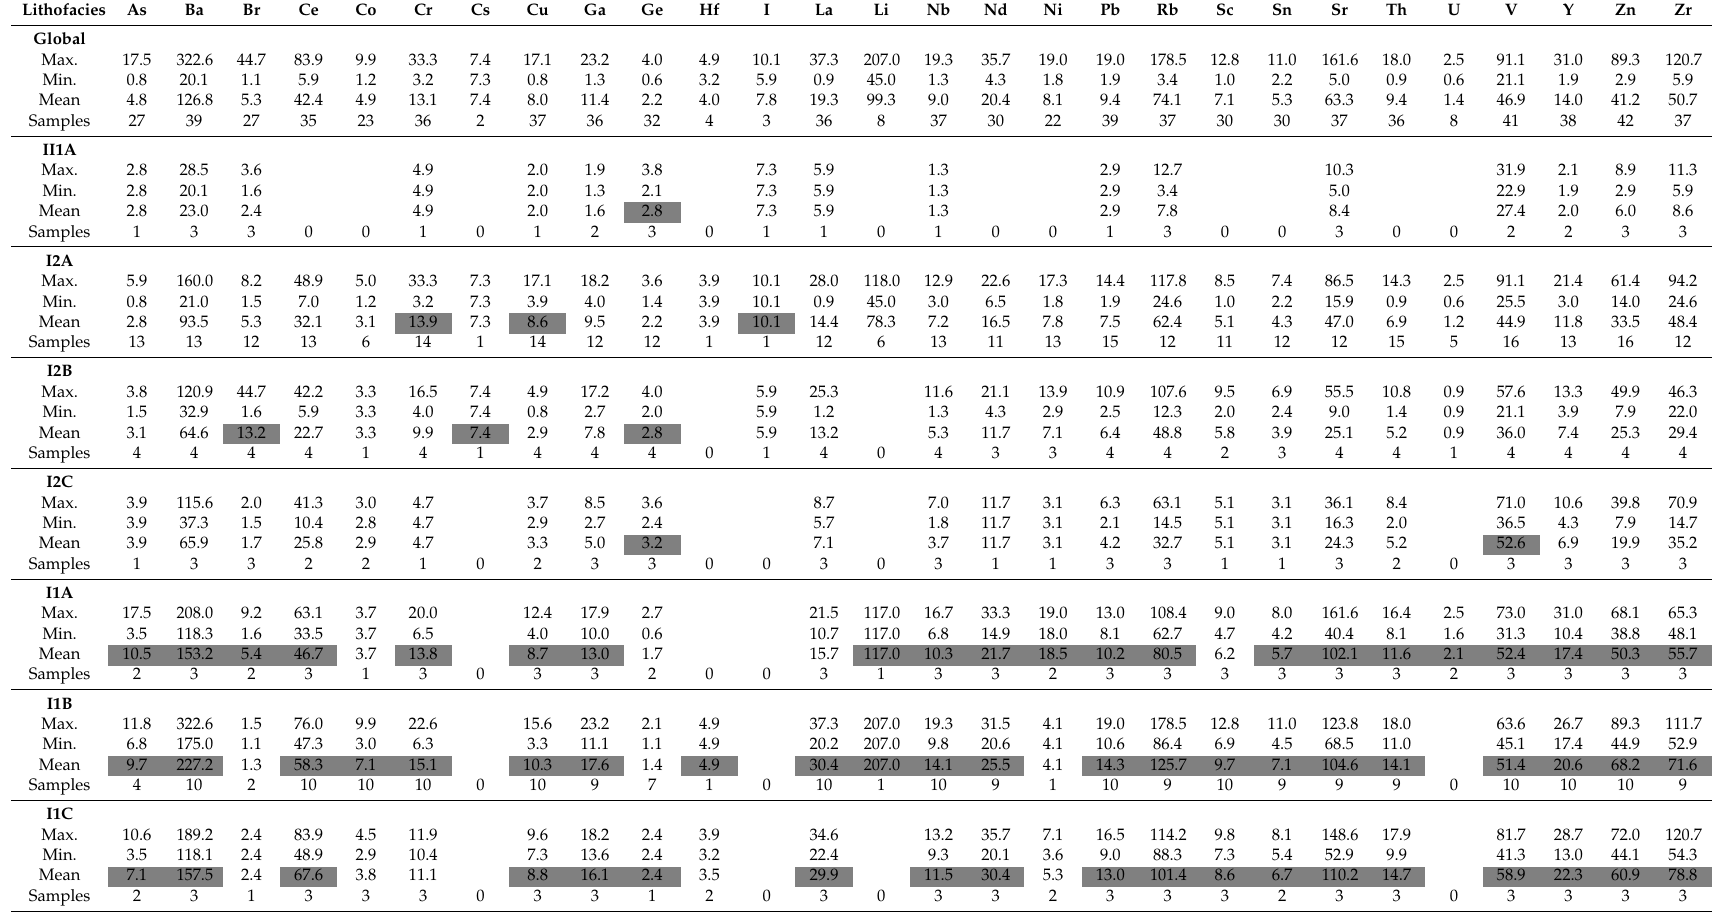
Table A3. Summary of the maximum, minimum and mean values (ppm) of the data obtained from the trace element analyses. The highlighted average values (white text on dark gray background) show results that exceed the global average value. Elements with data below the limit of detection have not been considered. Lithofacies As Ba Global